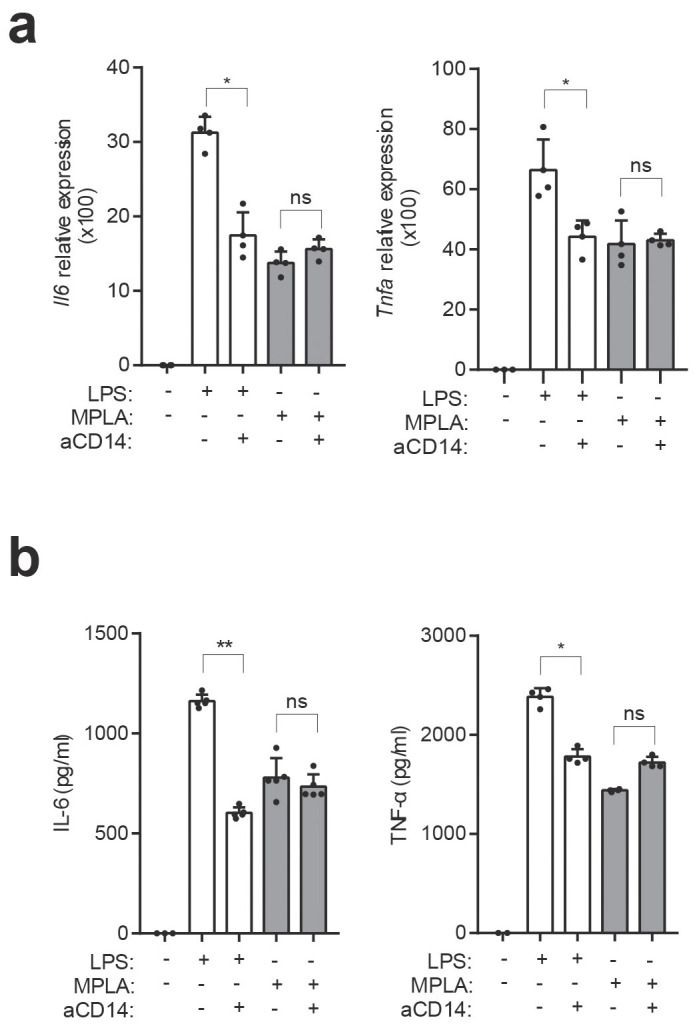
Anti-CD14 reduced LPS, but not MPLA, induced cytokine production.(a) Expression of Il6 and Tnfa genes analyzed by qPCR from BMDM treated for 10 min with a blocking αCD14 antibody (clone M14-23, 20 μg/mL, 4°C), and then cells were incubated for 4 hr with LPS (10 ng/mL) or MPLA (1 μg/mL) at 37°C. (b) Release of IL-6 and TNF-α from BMDMs treated as in (a). Each dot represents a single independent experiment; mean ± standard error is represented in all panels; n = 4–5 independent experiments; *p<0.05; **p<0.01; ns, no significant difference (p>0.05); Mann–Whitney test.